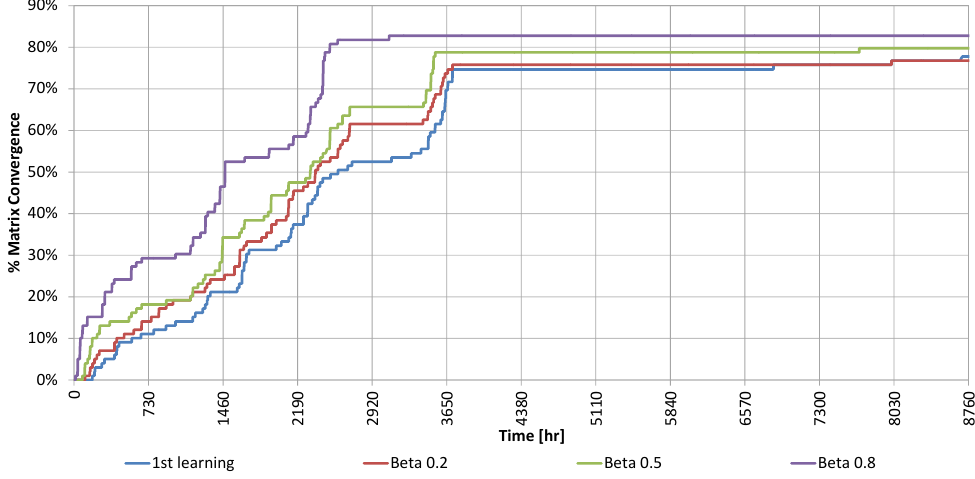
Figure 16. Convergence of the learning method comparing the first learning and re-learning with different β values (0.2, 0.5, 0.8).